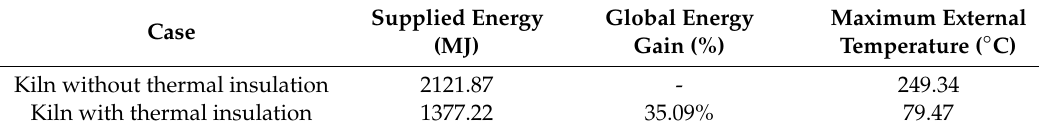
Table 8. Kiln’s performance data with and without thermal